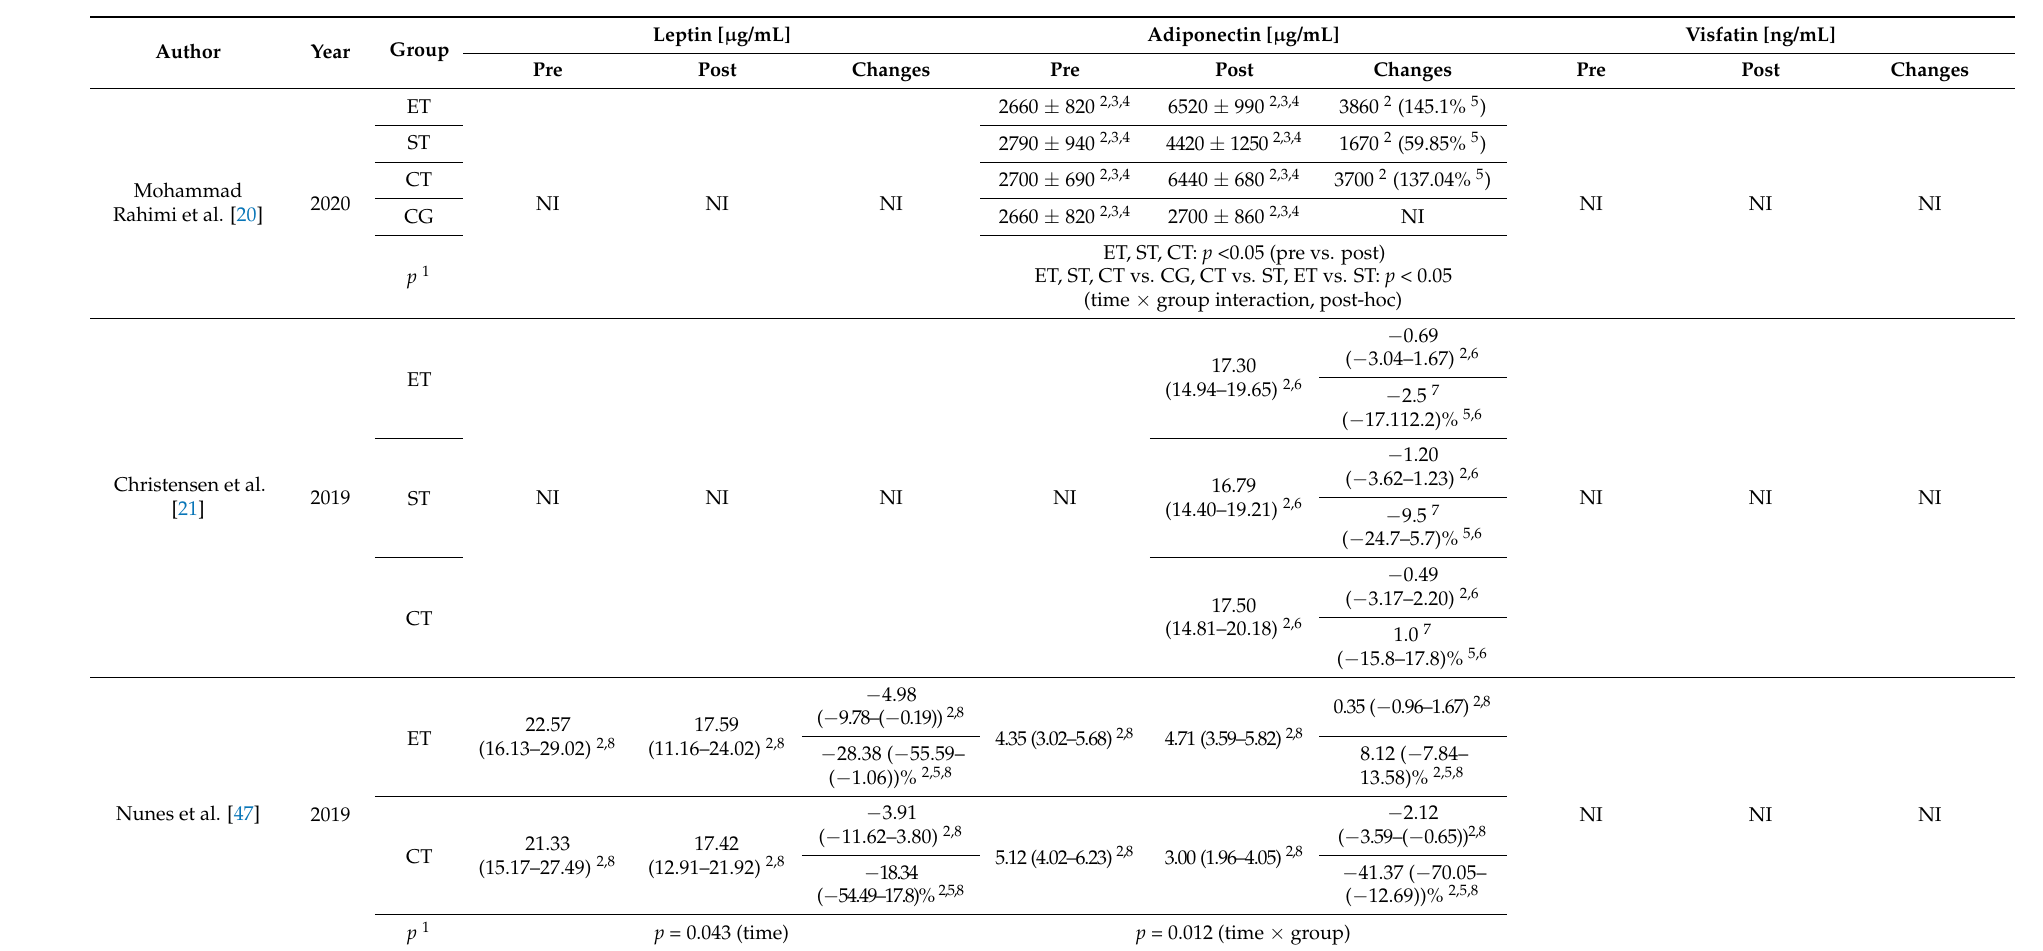
Table 4. Adipokines levels in studied